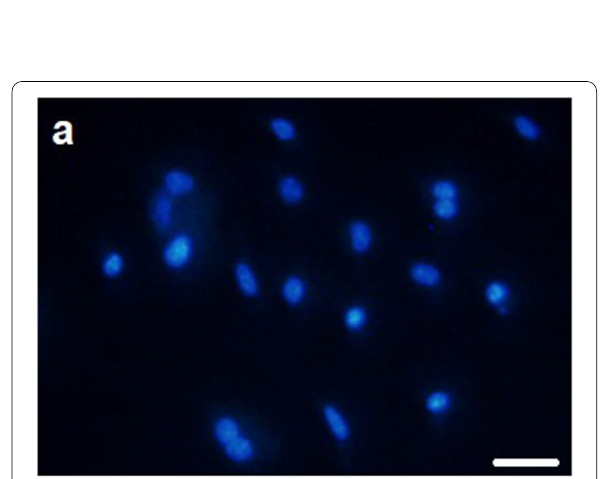
Fig. 2 Immunofluorescent graph of grown cells on silk scaffold. Spermatogonia stem cells were grown on the silk scaffold stained with DAPI